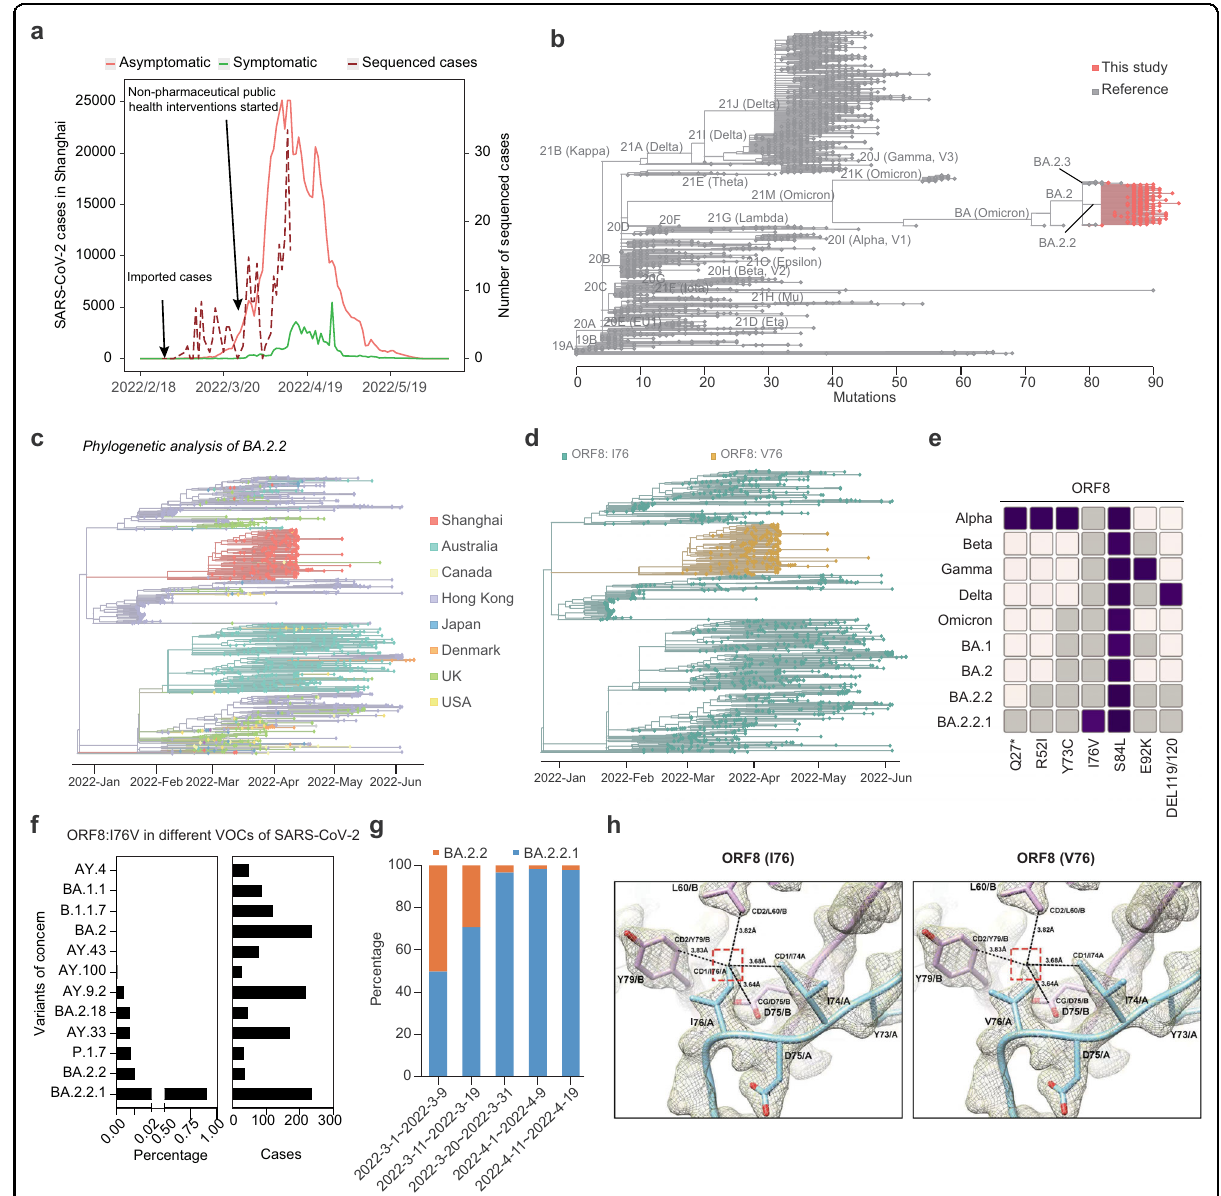
Fig. 1 Molecular characterization of the Omicron variant driving the wave of SARS-CoV-2 outbreak in Shanghai during spring 2022. a Sample collection times during the recent COVID-2019 outbreak in Shanghai. Total COVID-19 cases are shown in solid lines (red: asymptomatic cases; green: symptomatic cases). Sequenced cases are shown in dashed line. The timeline of the fi rst imported case report and the start of public health interventions are indicated. b Phylogenetic analysis of SARS-CoV-2 variants. SARS-CoV-2 reference genomes are shown in gray; 253 SARS-CoV- 2 genomes in Shanghai are shown in red. Main SARS-CoV-2 subvariants are indicated. c Phylogenetic analysis of SARS-CoV-2 genomes grouped under the BA.2.2 subvariant. Each color indicates the region where each genome was reported from. d Phylogenetic tree under the BA.2.2 subvariant as in c . The yellow color indicates genomes carrying BA.2.2.1-characteristic mutation: A28119G (ORF8:I76V). e Mutation pro fi les of selected SARS-CoV- 2 VOCs. Affected amino acid residues are shown below. Color gradient indicates relative mutation frequencies. Non-mutated sites are colored in gray. f The percentages and case numbers of various VOCs of SARS-CoV-2 with the A28119G (ORF8:I76V) mutation. g The percentage of BA.2.2.1-infected cases increased over time during the COVID-19 outbreak in Shanghai. h I76V at the noncovalent dimerization interface observed in the crystal structure of ORF8 (Protein Data Bank accession code: 7JTL) involving 73 YIDI 76 . ORF8 models are shown as cartoon, and colored in cyan (chain A) and pink (chain B). Electron density (2 F O − F C map, contoured at 1.5 σ ) is illustrated as gray mesh. van de Waals interactions involving a side-chain carbon (CD1) of I76 are indicated as dashed lines (left panel). A simple I76V mutation is introduced and V76 is re fi ned in real space (right